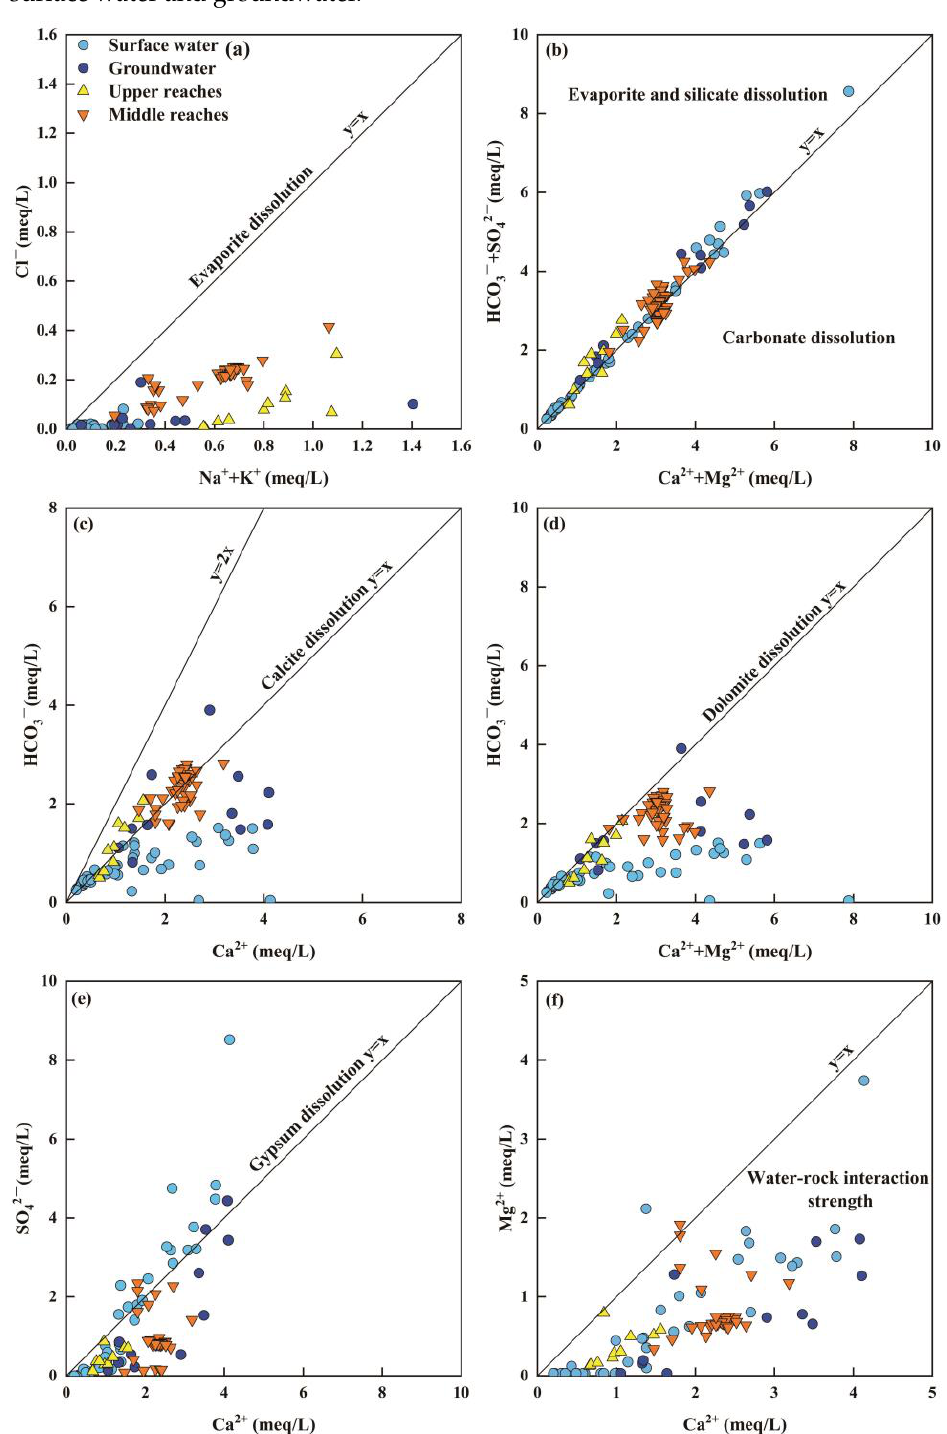
Figure 9. Molar ratio diagram of ion combination. Data were from Tables 1 and 2. ( a ) (K + + Na + )/Cl − ; ( b ) (Ca 2+ + Mg 2+ )/(HCO 3 − + SO 4 2− ); ( c ) Ca 2+ /HCO 3 − ; ( d ) (Ca 2+ + Mg 2+ )/HCO 3 − ; ( e ) Ca 2+ /SO 4 2− ; ( f ) Ca 2+ /SO 4 2− .